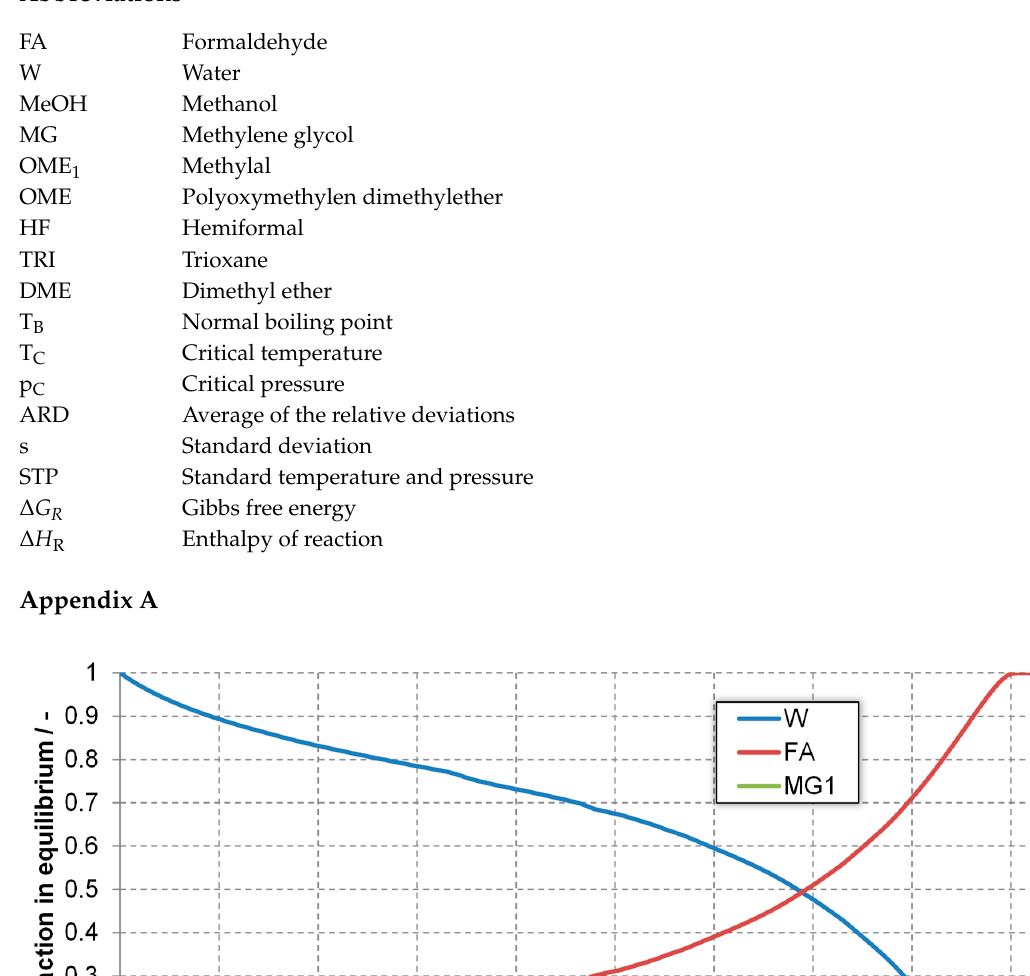
Figure A1. Equilibrium distribution in the gas phase of the component system FA-W at 90 °C.